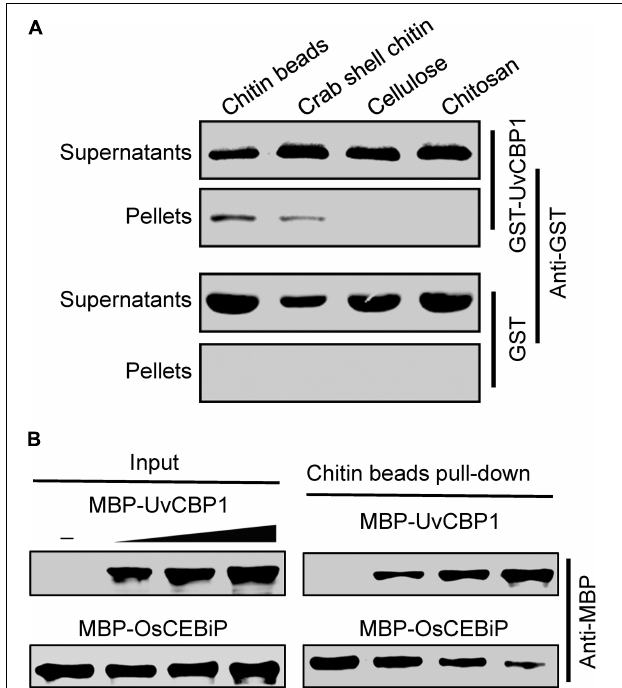
FIGURE 5 | UvCBP1 competes with rice chitin receptor OsCEBiP to bind with free chitin. (A) Chitin-binding assay. The recombinant protein GST-UvCBP1 was incubated with insoluble chitin beads, shrimp shell, cellulose, and chitosan. GST protein was used as control. After incubation and elution, the pellets (P) and supernatant (S) were detected by Western blot with an anti-GST antibody. (B) UvCBP1 competes with OsCEBiP for chitin binding. Increasing amounts of MBP-UvCBP1 was mixed with MBP-OsCEBiP, and the resultants were incubated with chitin beads. MBP-UvCBP1 or MBP-OsCEBiP pull-down by chitin beads was detected with an anti-MBP